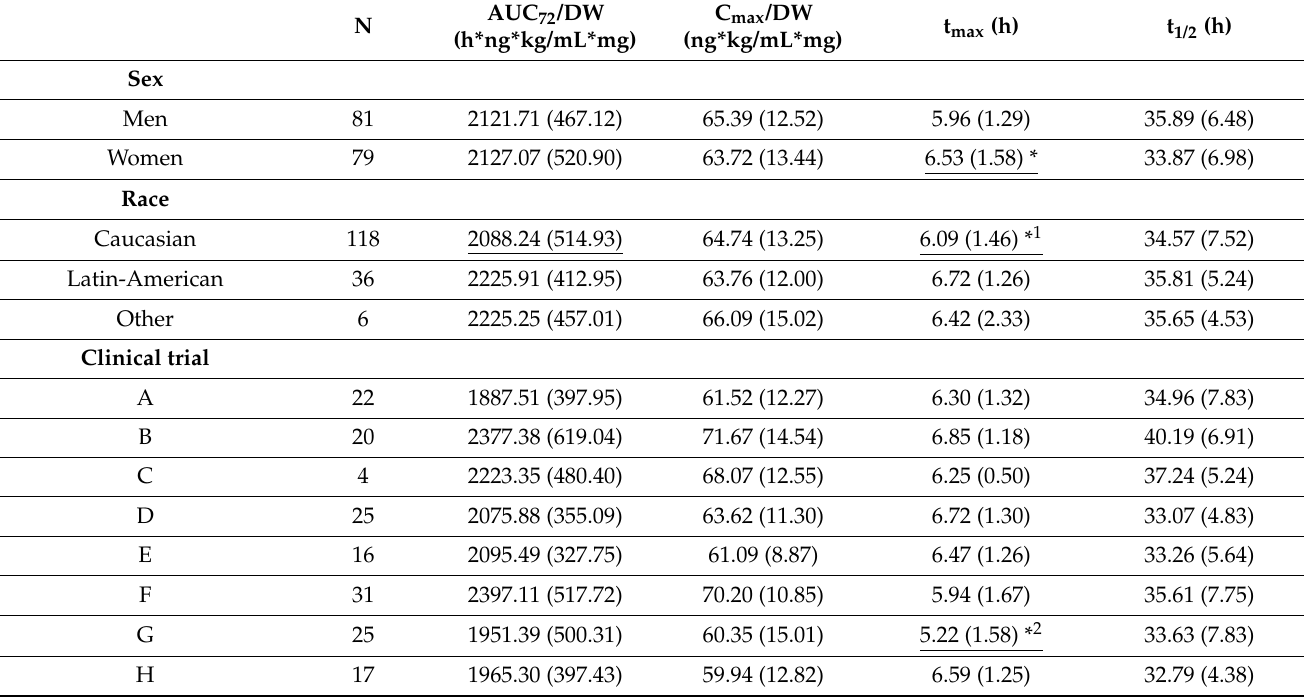
Table 3. Pharmacokinetic parameters regarding sex, race, clinical trial and co-administered